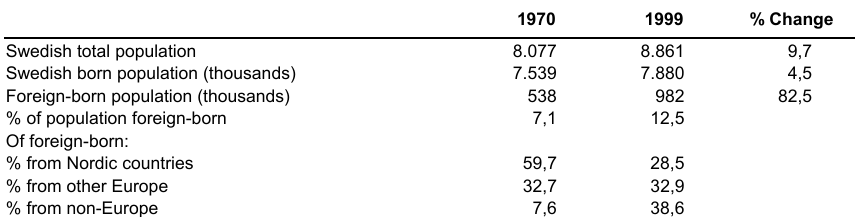
Table 1. Changing Swedish society: More foreign-born, more non-European 1970 1999 % Change Swedish total population 8.077 8.861 9,7 Swedish born population (thousands) 7.539 7.880 4,5 Foreign-born population (thousands) 538 982 82,5 % of population foreign-born 7,1 12,5 Of foreign-born: % from Nordic countries 59,7 28,5 % from other Europe 32,7 32,9 % from non-Europe 7,6